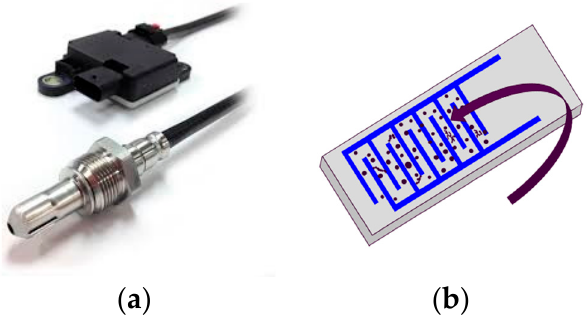
Figure 5. ( a ) Resistive soot sensor (Stoneridge Inc.) with its electronic control module (ECM) and sensor probe; ( b ) sensor element with soot particles (enlarged).